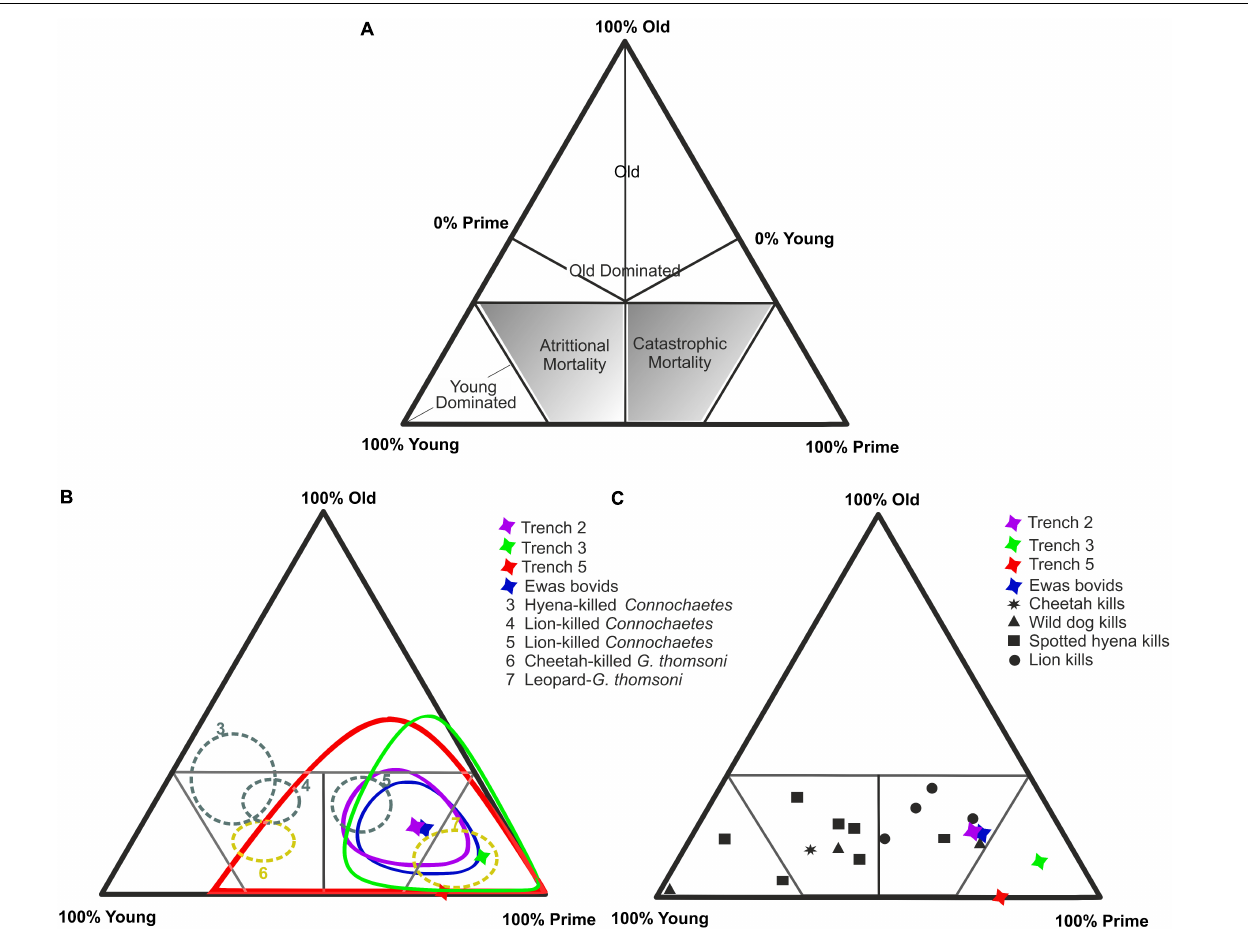
FIGURE 3 | Mortality pattern of the bovids from Ewass trenches 2, 3, and 5. Actualistic data from Stiner (1990) and modified by Bunn and Pickering (2010). (A) Triangular mortality diagram showing the different mortality patterns described by Stiner (1990). Panels (B,C) modified triangular graphs comparing with actualistic data of several